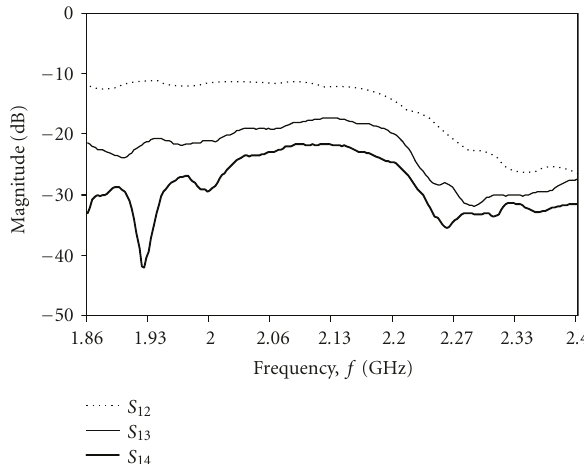
Figure 4: Measured coupling between element 1 and other elements of the 4 × 1 LIEH-shaped